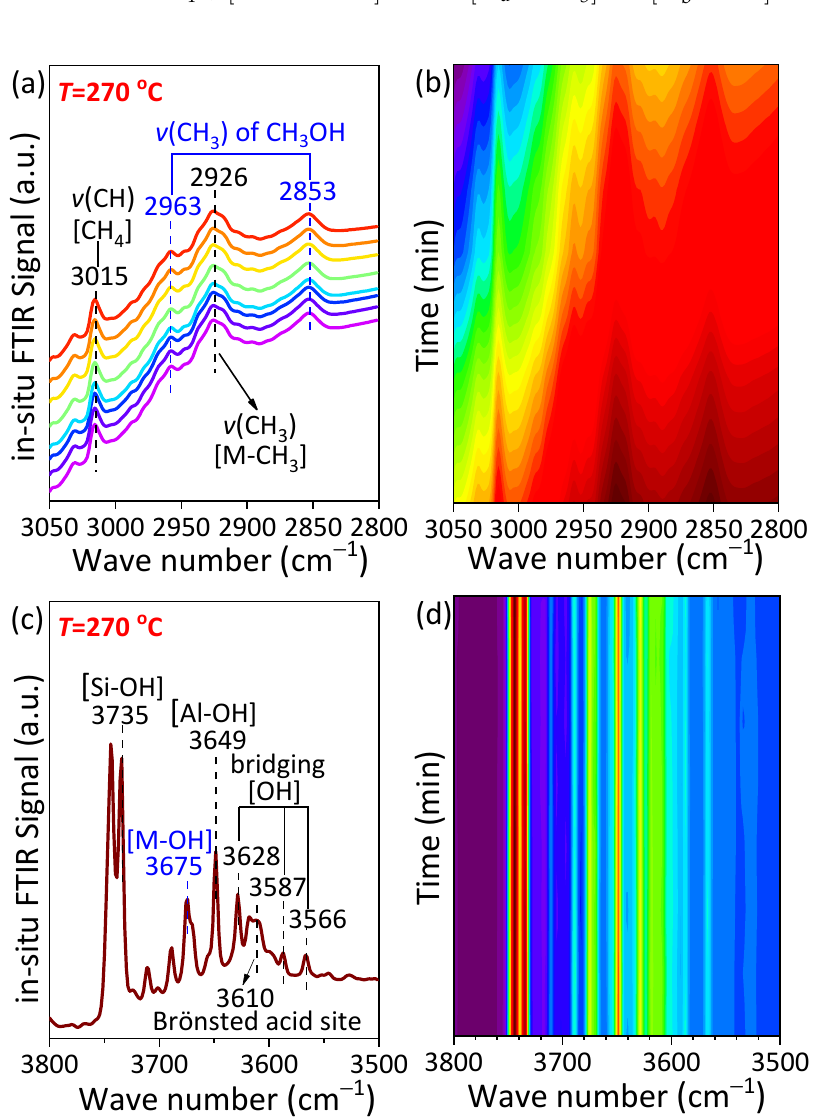
Figure 5. In situ FTIR spectra derived under different conditions over the Fe 0.60% Cu 0.68% -BEA: ( a , b ) co-feeding experiment of N 2 O (2 vol%, in He), CH 4 (2 vol%, in He) and H 2 O (bubbled by the mixed flow of 40 mL ∙ min − 1 ) at a time interval of 0.5 min ( T = 270 °C), wherein the sample was pretreated in situ for 1 h at T = 500 °C under vacuum conditions; ( c , d ) after the vacuum ( T = 500 °C, 1 h) and subsequent N 2 O (2 vol% in He, T = 270 °C of 1 h) pretreatment, the IR signal begins to be monitored along with the interaction with CH 4 (2 vol%, in He).